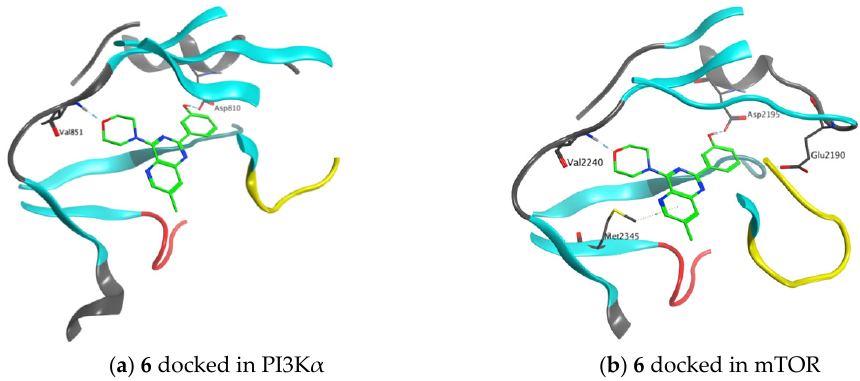
Figure 4. Binding modes for compound 6 on the two studied targets PI3K α and mTOR.